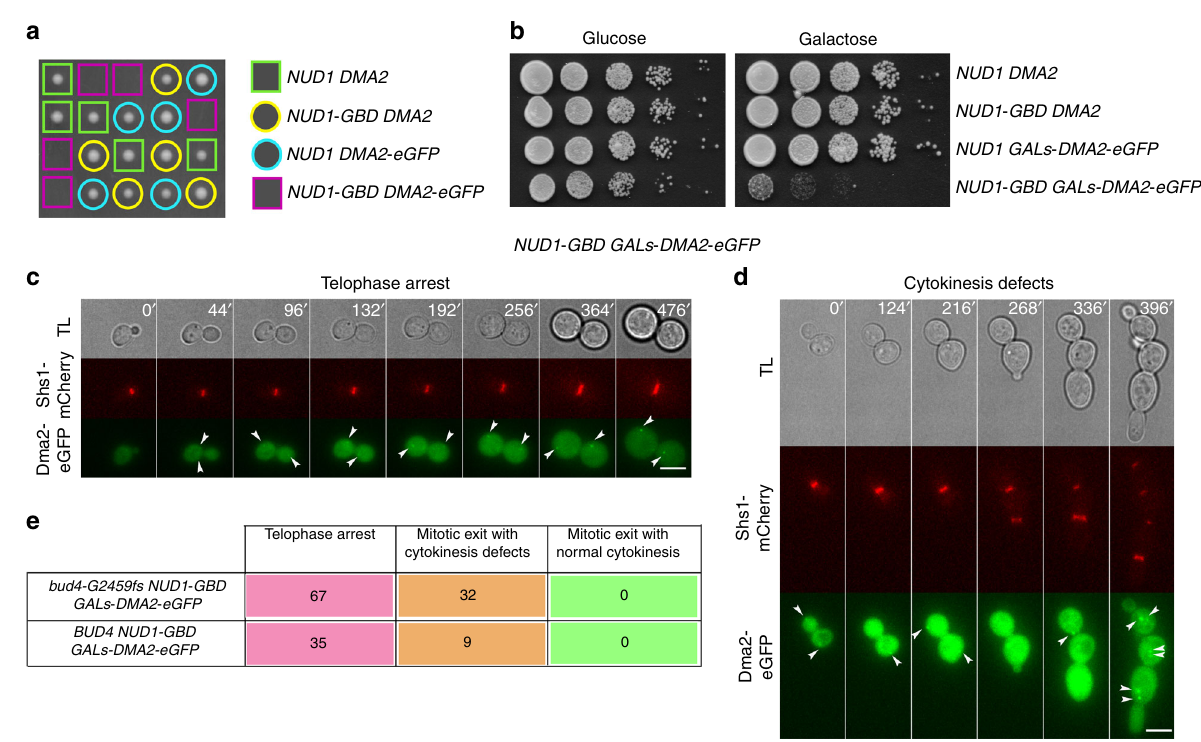
Fig. 6 Constitutive association between Dma2 and Nud1 prevents mitotic exit and cytokinesis. a Meiotic segregants obtained after sporulation of diploid cells generated by crossing NUD1-GBD with DMA2-eGFP haploid cells. Genotypes were con fi rmed by PCR. b Serial dilutions of cells with the indicated genotypes were spotted on YEPD and YEPG plates and incubated at 30 °C. c – e NUD1-GBD GALs-DMA2-eGFP cells, either BUD4 or bud4-G2459fs , expressing Shs1-mCherry and grown in SD-raf fi nose were induced for 90 min with galactose and then imaged in SD-raf fi nose/galactose at 30 °C every 4 min. c Telophase arrest; d cytokinesis defects; e number of cells showing the indicated phenotypes in the movies. Arrowheads indicate Dma2-eGFP at SPBs. TL transmitted light. Scale bar: 5 µ